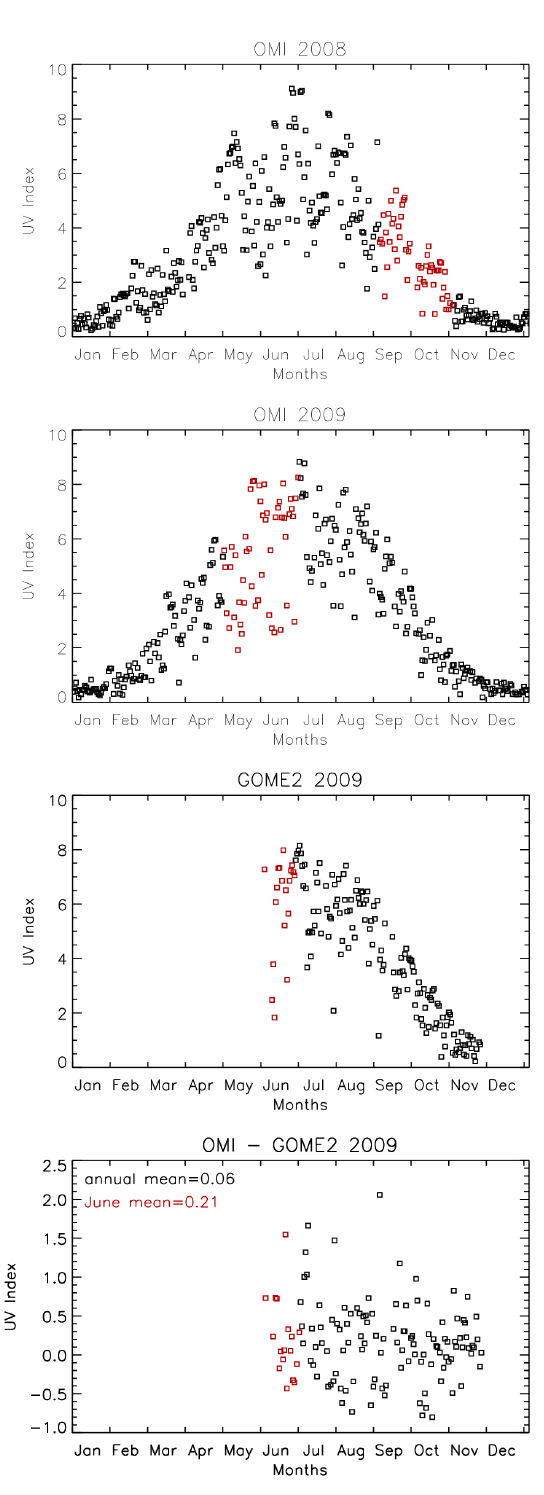
Fig. 3. OMI and GOME2 (all-sky data) satellite 2008 (top) and 2009 (middle) UVI products. Bottom figure: absolute mean differ- ence between OMI and GOME2 products for 2009. Red squares: RISC UV campaign